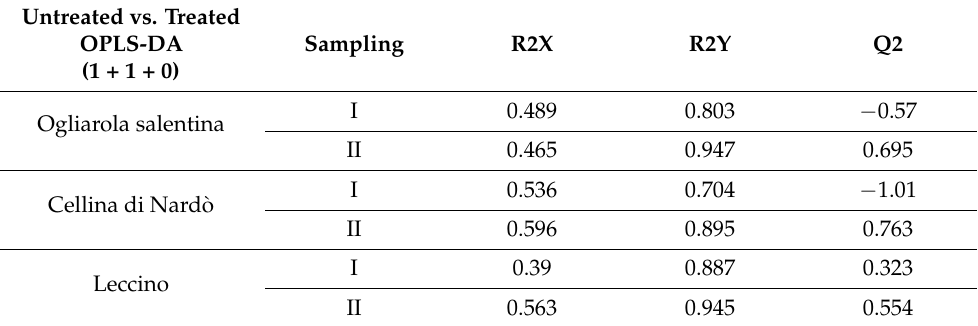
Table 3. Statistical parameters of supervised OPLS-DA models for untreated and treated naturally infected Leccino, Ogliarola salentina and Cellina di Nard ò cultivars. R2X and R2Y indicate the fraction of variance of the X and Y matrix, respectively. Q2 is a goodness of prediction parameter representing the portion of variance in the data predictable by the